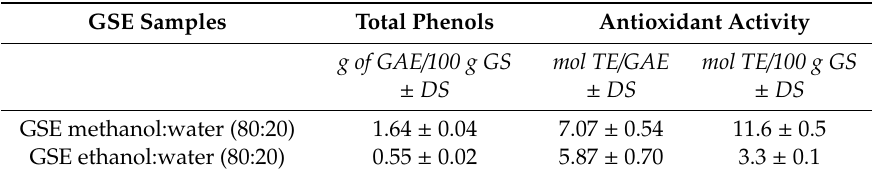
Table 1. Total phenol content and antioxidant activity of grape seed polyphenolic extracts